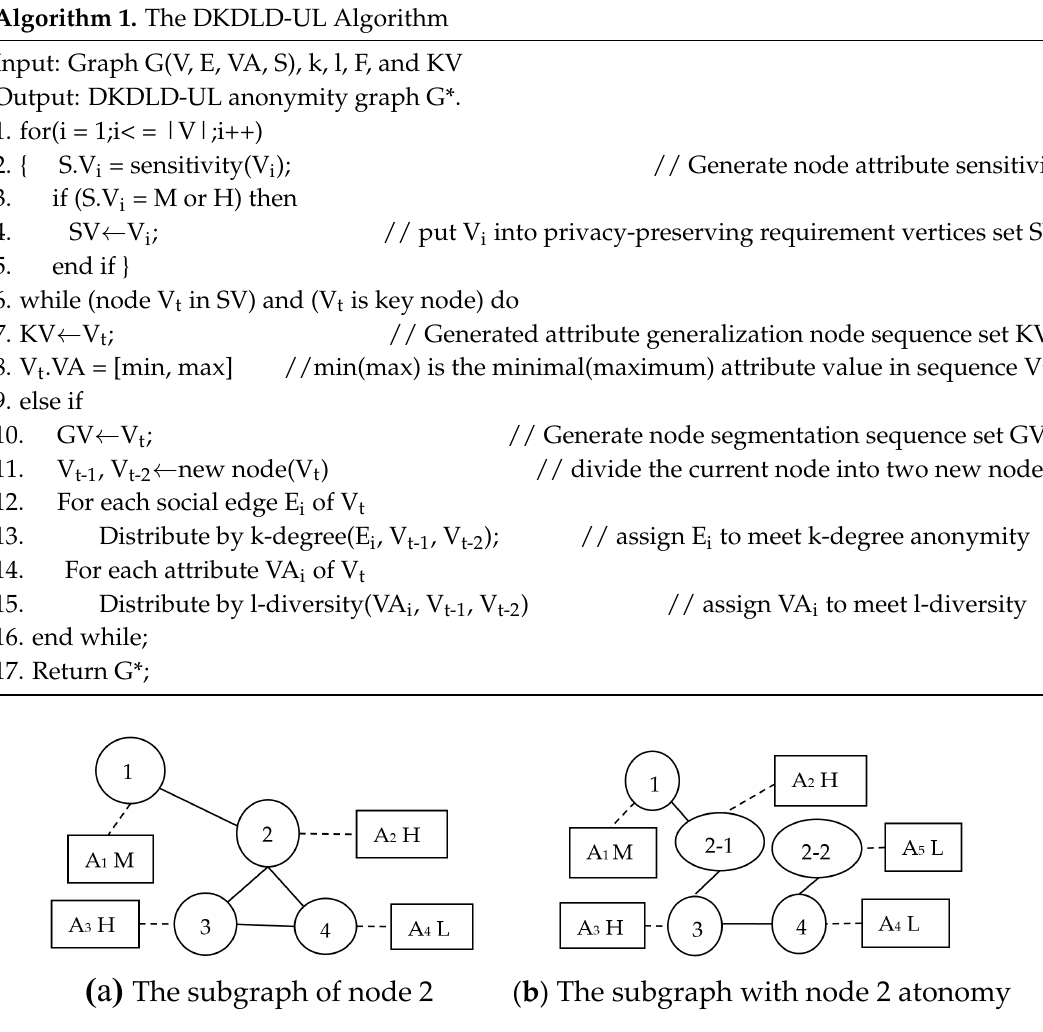
Algorithm 1. The DKDLD-UL Algorithm